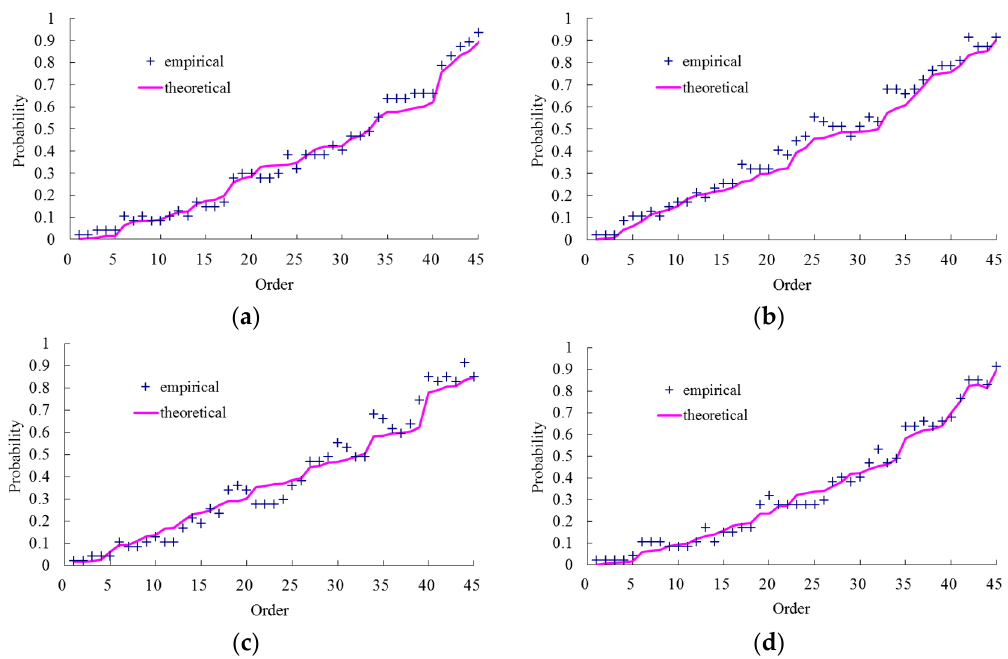
Figure 3. Plots of empirical and theoretical values for four joint cumulative distribution functions (CDFs). Note: Order represents number of ordered pair, ranked in the ascending order in terms of theoretical joint CDF, respectively. ( a ) Geheyan and Ge-Gao inter-basin; ( b ) Shuibuya and Shui-Ge inter-basin; ( c ) Shuibuya and Ge-Gao inter-basin; and, ( d ) Shuibuya, Shui-Ge, and Ge-Gao inter-basins. Table 3. Estimated parameters of the G-H copula function and Cramer-von Mises test. Variables τ θ / [ θ 1 , θ 2 ] p -Value (a) W 3 at Geheyan reservoir site and Ge-Gao inter-basin